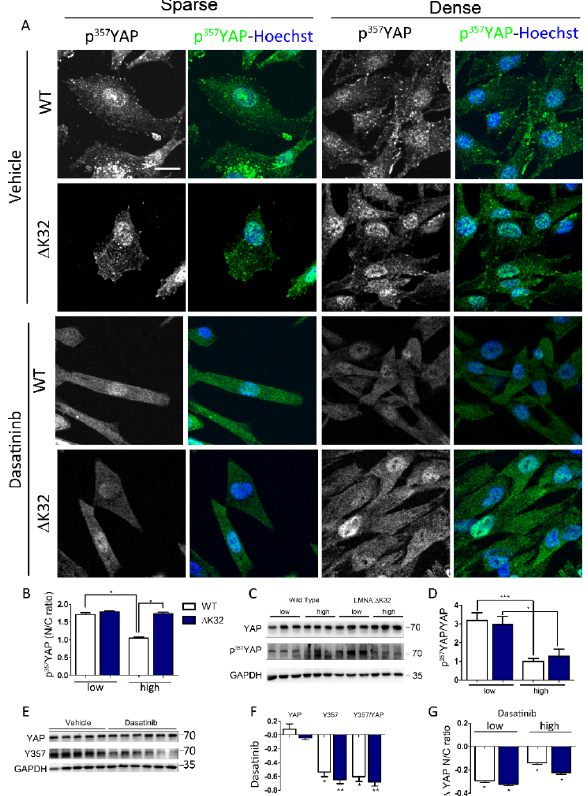
Figure 3. Y357 phosphorylation of YAP in WT and LMNA mutated MuSCs. ( A ) Confocal images